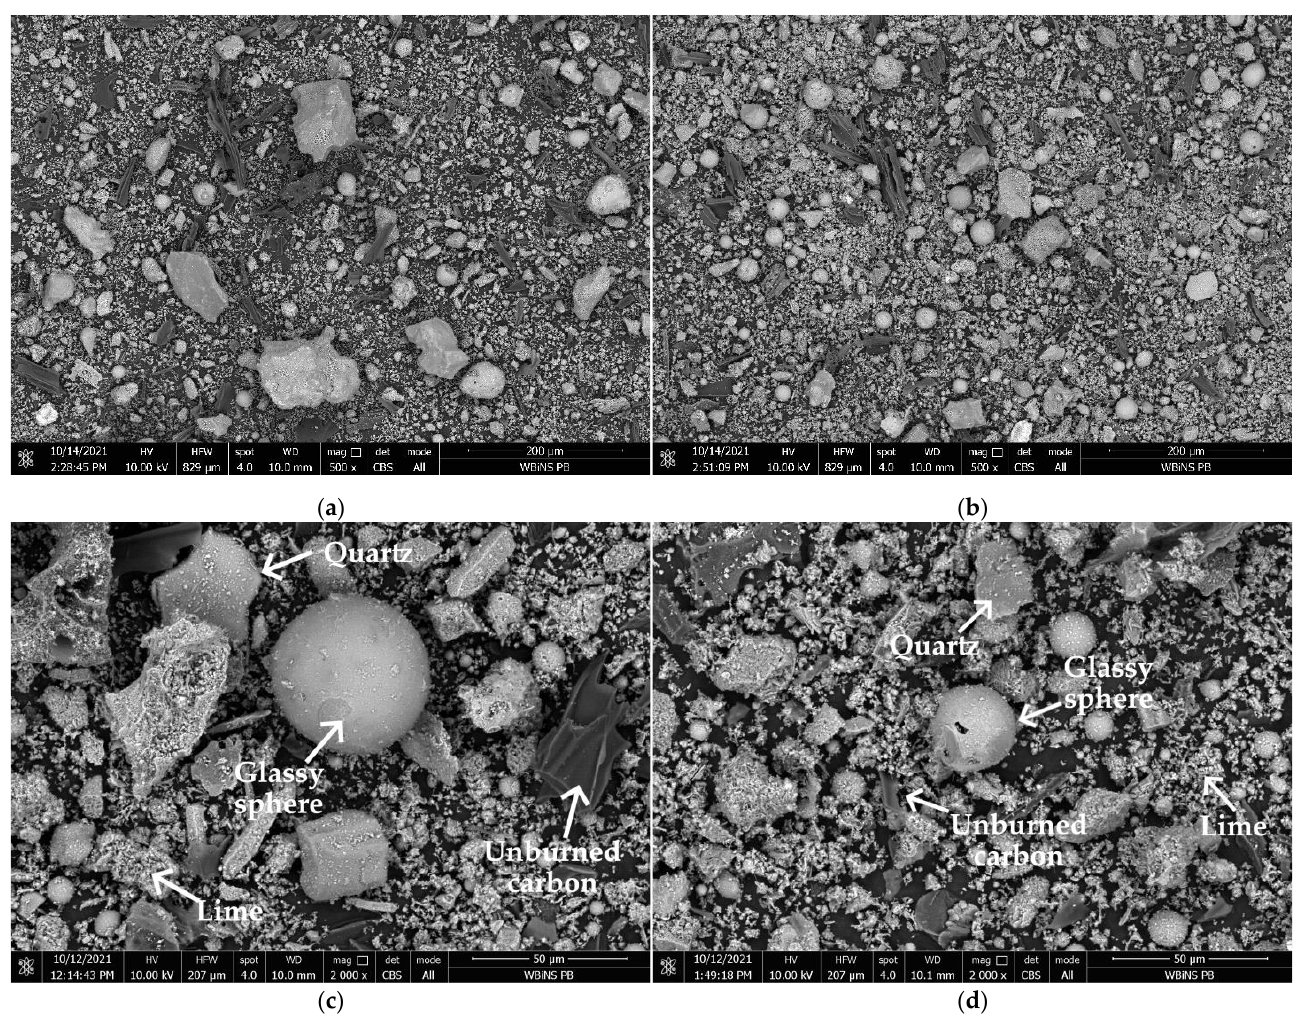
Figure 3. SEM photographs of fly ash ( a ) untreated (FA(B)N) (500x magnification), ( b ) sieved with 63 µm (FA(B)63) (500x magnification), ( c ) untreated (FA(B)N) (2000x magnification), and ( d ) sieved with 63 µm (FA(B)63) (2000x magnification). Table 6. Chemical oxide composition of sieved biomass fly